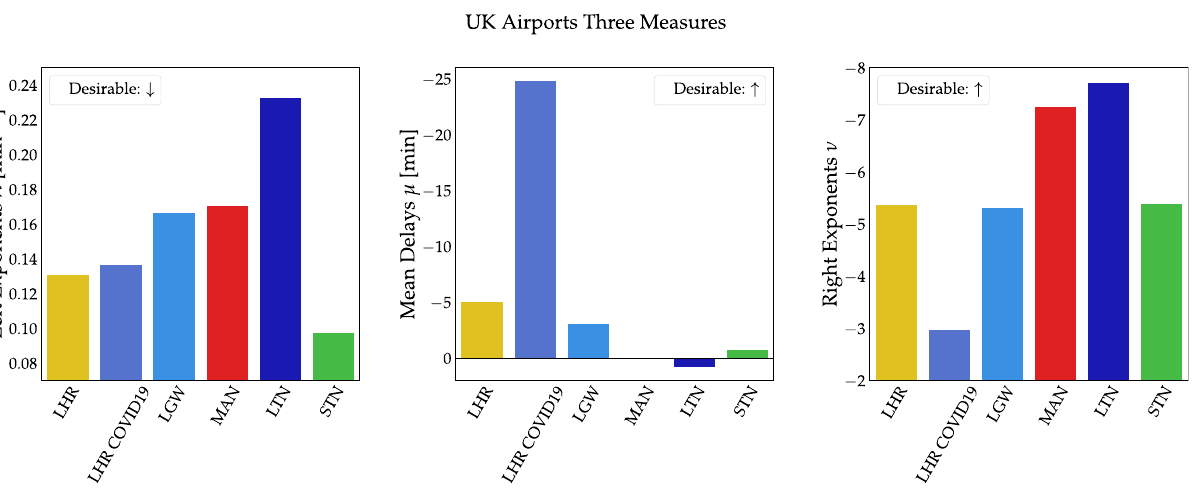
Figure 6. Airports appear to differ substantially in the three delay metrics. Airports that serve mostly domestic and European destinations, such as LTN and STN, behave differently from international airports such as LHR, LGW and